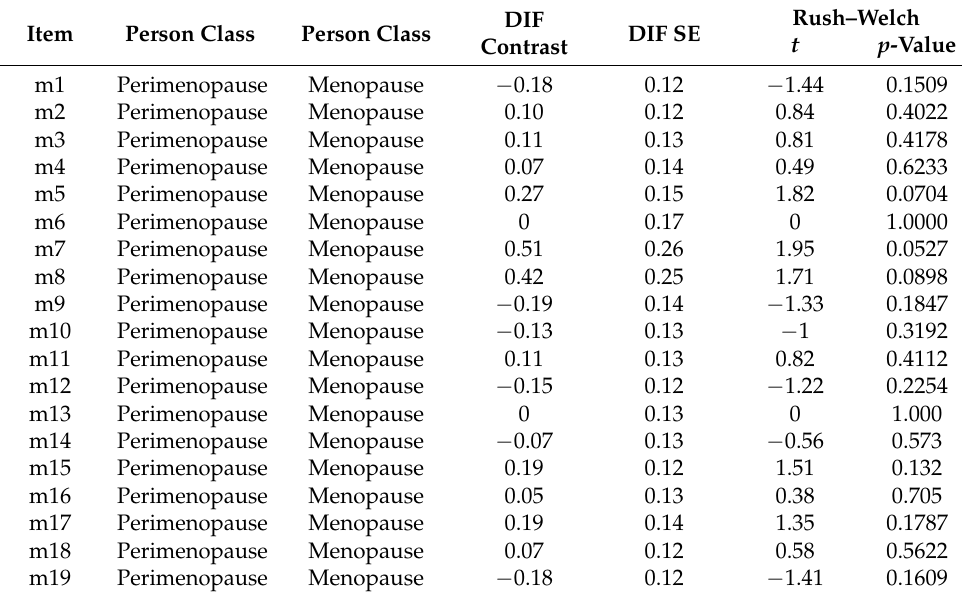
Table 5. Differential item functioning (DIF)